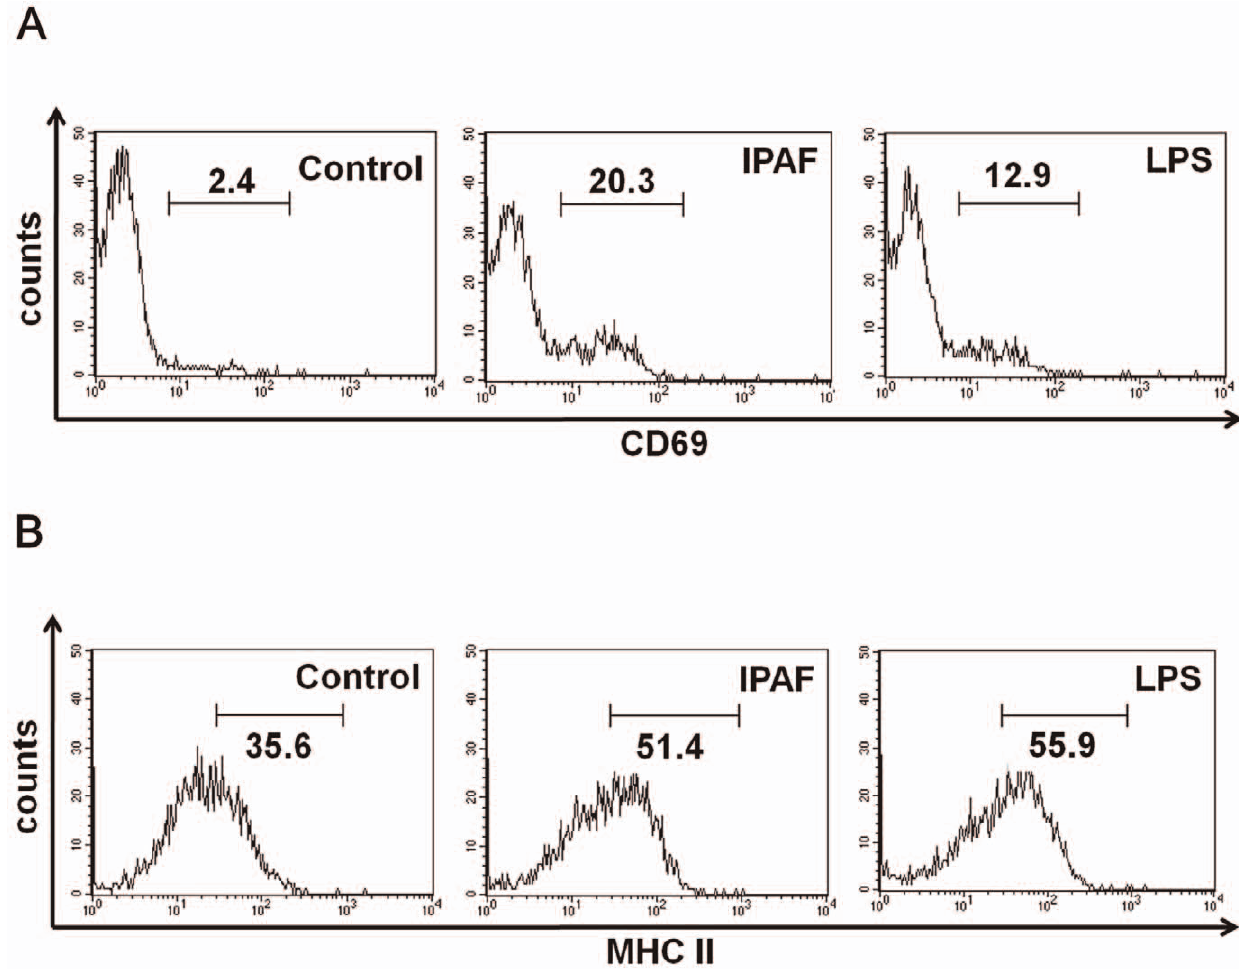
Figure 4. IPAF stimulated the expression markers in mouse splenic B lymphocytes. (A) Splenic B lymphocytes of BALB/c were stimulated with 30 m g/mL IPAF (middle), 10 m g/mL LPS (right), or medium alone (left) for 24 hours. Cells were stained with PE-labeled anti-mouse CD69 for flow cytometry analysis. Data are presented as percentage of CD69 positive cells in total cells. (B) Splenic B lymphocytes of BALB/c were stimulated with 30 m g/mL IPAF (middle), 10 m g/mL LPS (right), or medium alone (left) for 24 hours. Cells were stained with FITC-labeled anti-mouse MHC class II for flow cytometry analysis. Data are presented as percentage of MHC class II positive cells in total cells.